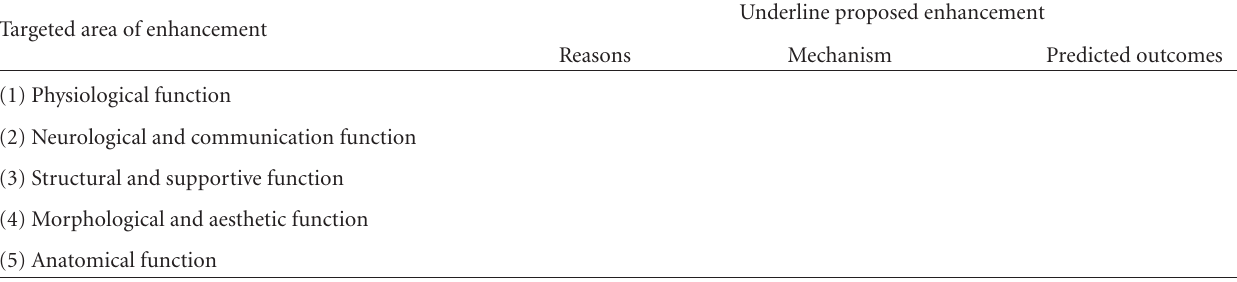
Table 4: Identified targeted areas for enhancement within the selected areas in given human body systems and or its organs. Targeted area of